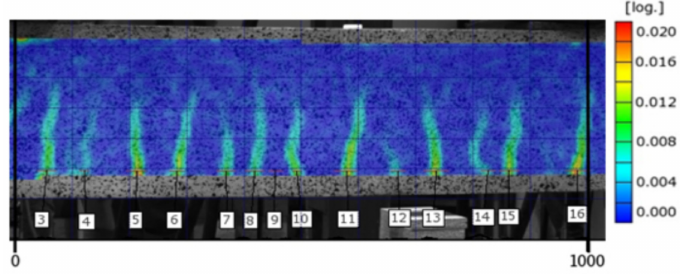
Figure 14. Strain map for beam C2M-1 at the load level of 0.75.